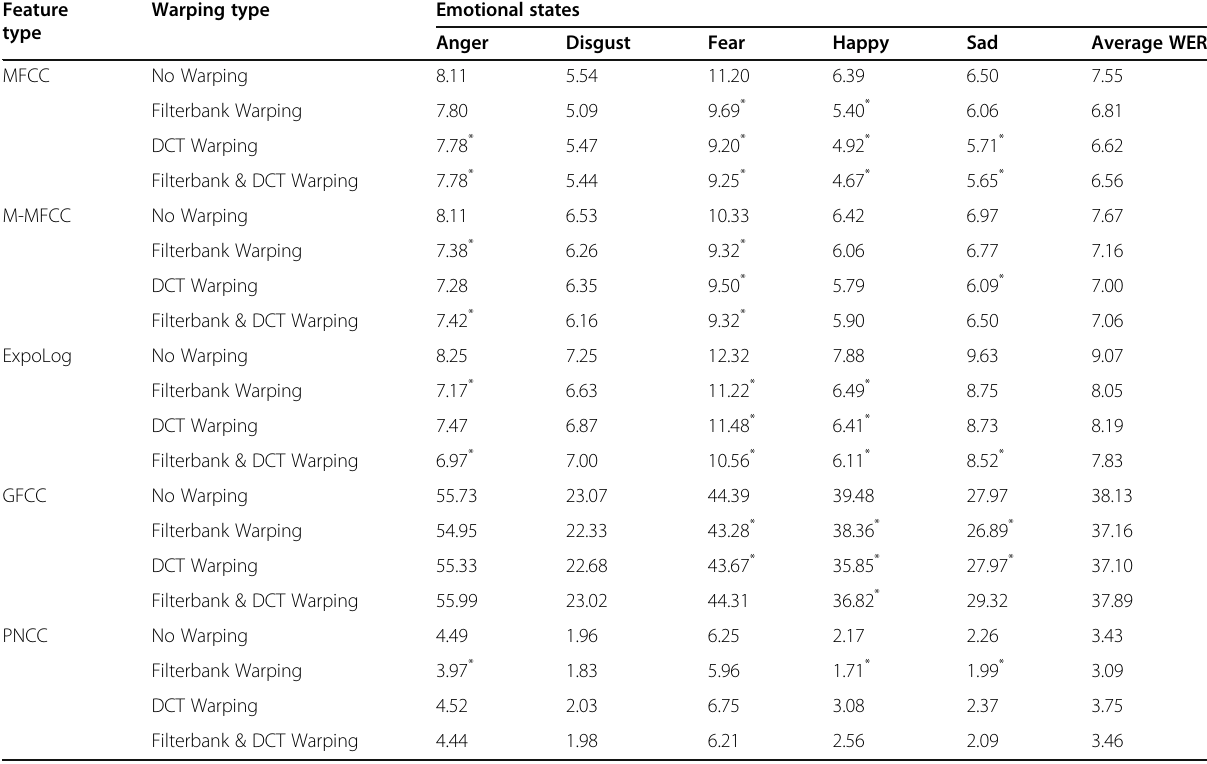
Table 5 The recognition performance of the proposed GMM-HMM EASR system (in terms of WER (%)) for CREMA-D. The values of WER are obtained by applying different warping methods to various acoustic features extracted from different emotional utterances. The symbol * shows statistically significant cases (i.e., p value <